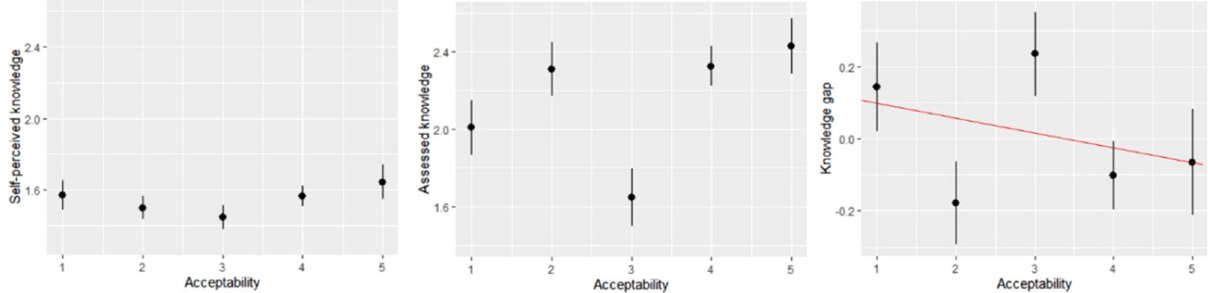
Fig. 2 Assessed and self-perceived knowledge for different levels of carbon-tax acceptability. Data are presented as mean values with error bars representing + / − 2 s.e. Acceptability is measured on a 5-point scale ranging from 1 = completely unacceptable to 5 = completely acceptable. The red line in the right plot indicates a fi tted linear model. Subgroups sizes are: N = 382 for acceptability level 1, N = 374 for acceptability level 2, N = 387 for acceptability level 3, N = 589 for acceptability level 4, and N = 272 for acceptability level 5.